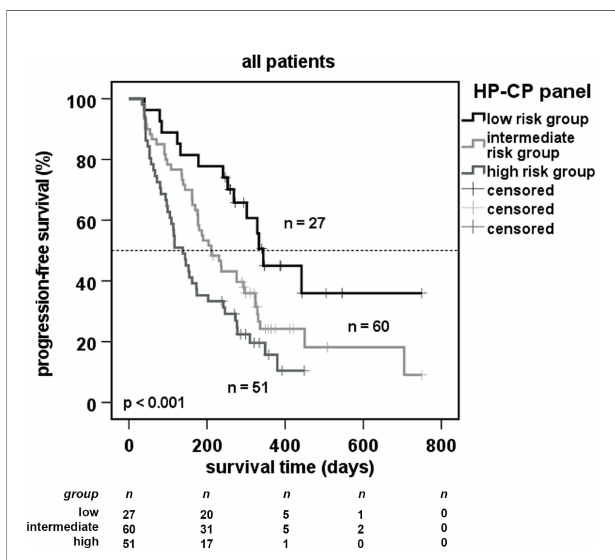
FIGURE 3 | Predictive progression-free survival of patients using a 2-marker- panel of acute phase proteins. Cut-off values used in Figure 2 were combined for robust markers of multivariate analysis ( Table S4 ). Patients were separated in a low-risk group (serum values below cut-offs), a high-risk group (serum values above cut-offs) and an intermediate risk group (all other patients). Dotted line indicates the median survival of the